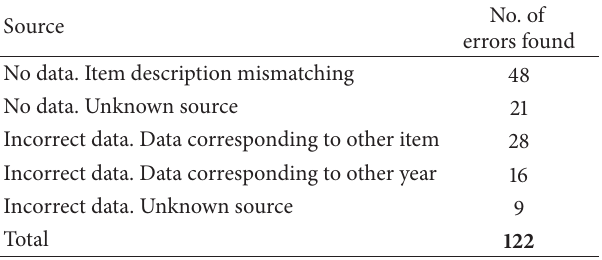
Table 4: Descriptions of errors given by participants.